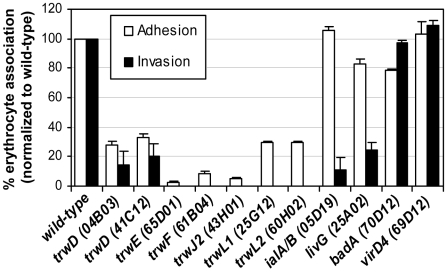
Role of Trw in erythrocyte infection.Efficiency of in vitro invasion of murine erythrocyte by abacteremic mutants of B. birtlesii. The in vitro erythrocyte adhesion or invasion phenotype of abacteremic mutants identified in the STM screen was evaluated at 2 DPI by flow cytometry after immunocytochemical staining of bacteria (see Figure S2) or at 1 DPI by the gentamicin protection assay, respectively. The efficiency of erythrocyte adhesion or invasion of each tested mutant is expressed as percentage of erythrocyte adhesion or invasion of the isogenic wild-type strain (mean +/- SD of triplicate samples). All mutants listed in Table S1 that do not appear in this figure display wild-type phenotype in regard of in vitro erythrocyte invasion.